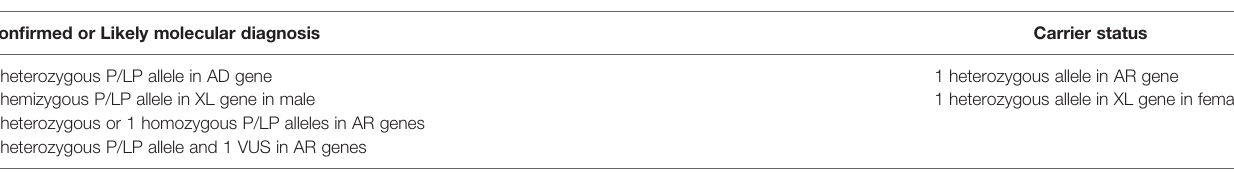
TABLE 1 | Clinical relevance of genetic test